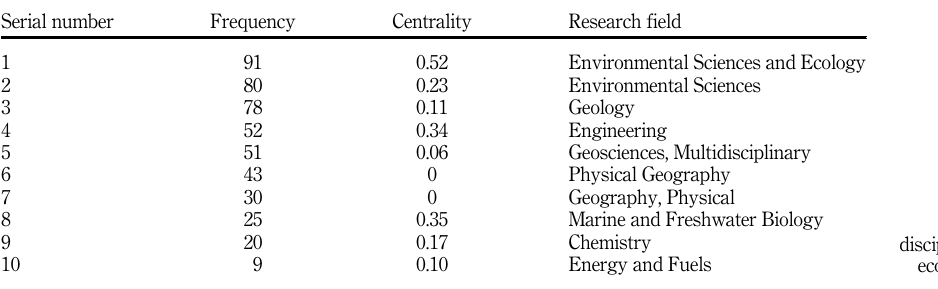
Table 1. Ranking of